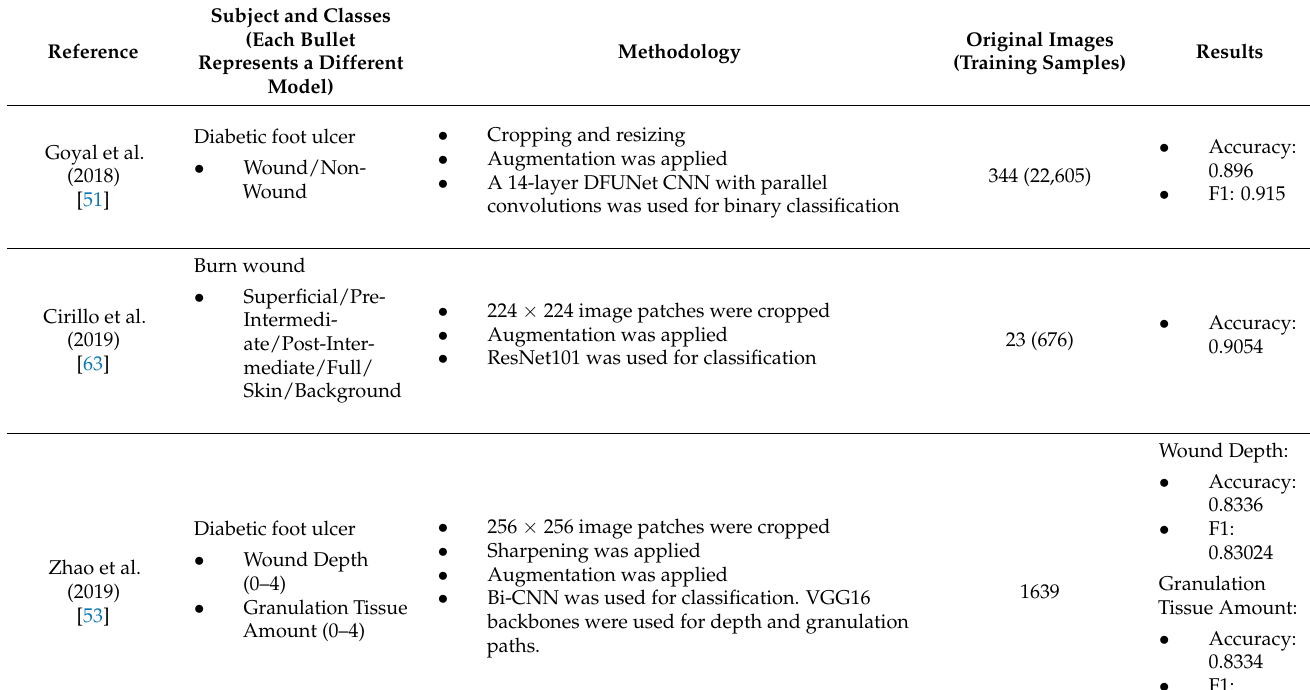
Table 4. Summary of studies on chronic wound